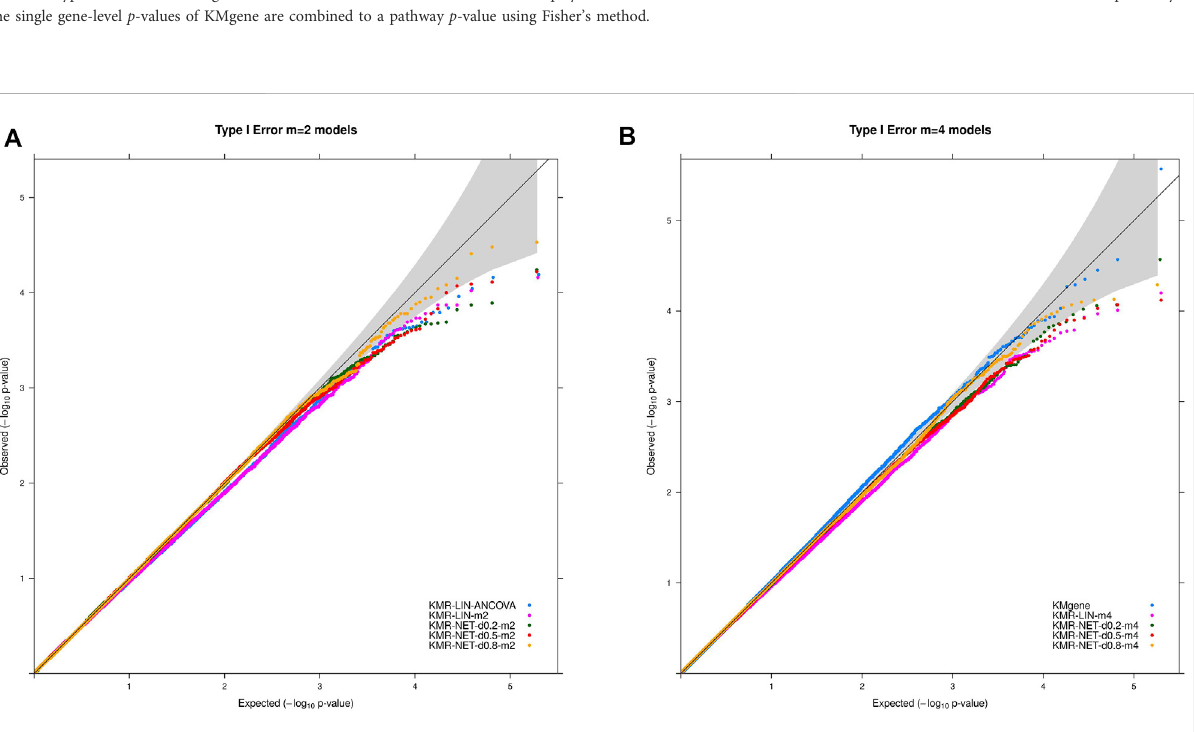
FIGURE 2 QQ-plots for the type I error rate for our simulation studies divided for the (A) two-measurement and (B) four-measurement models and the comparison model